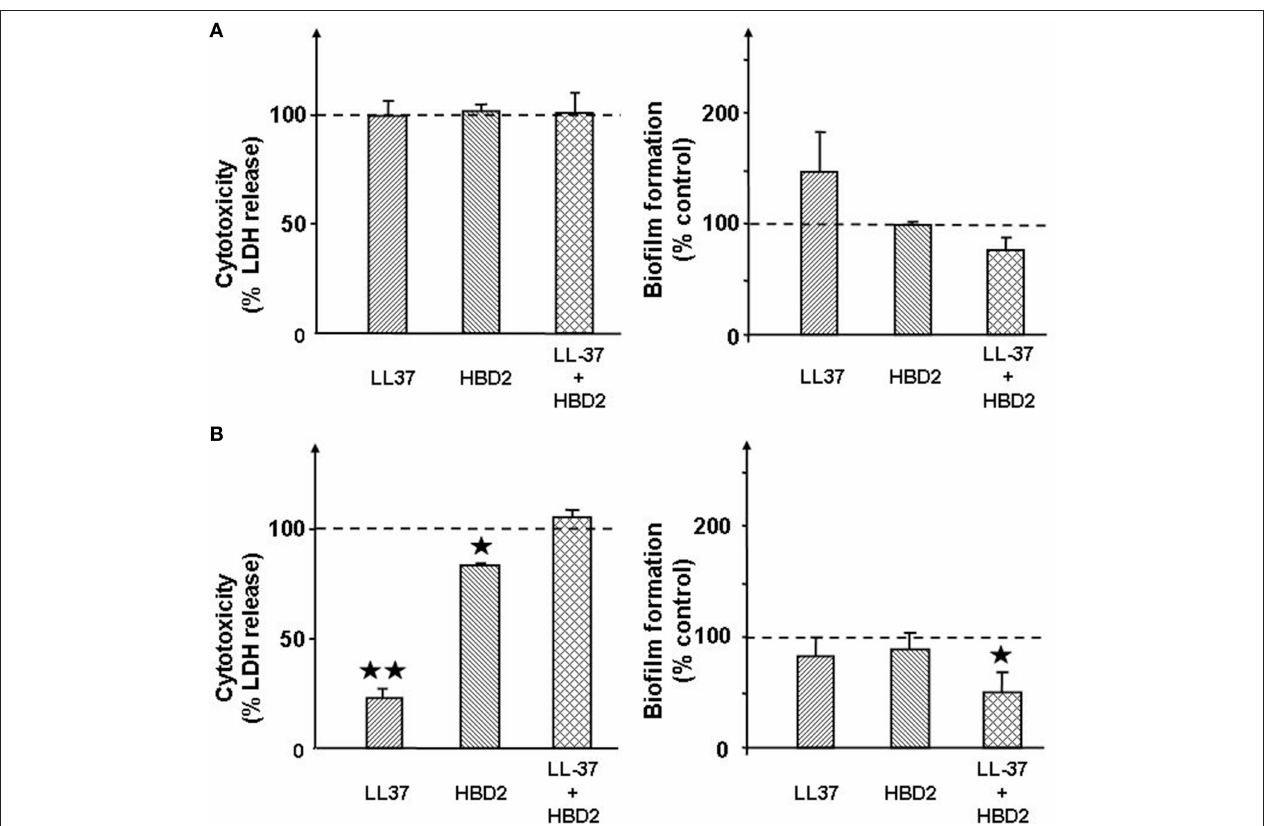
FIGURE 4 | Effect of the cathelicidin LL37 (1 µ g/mL) and of β -defensin 2 (HBD2) (1 µ g/mL) alone or in association on the cytotoxicity and biofilm formation activities of S. aureus MFP03 (A) and S. epidermidis MFP04 (B). Dotted lines indicate the basal cytotoxicity and biofilm formation activity of bacteria in the absence of treatment (control). Each value is the mean ± SEM of three independent experiments. ( ⋆ p < 0.05; ⋆⋆ p < 0.01).